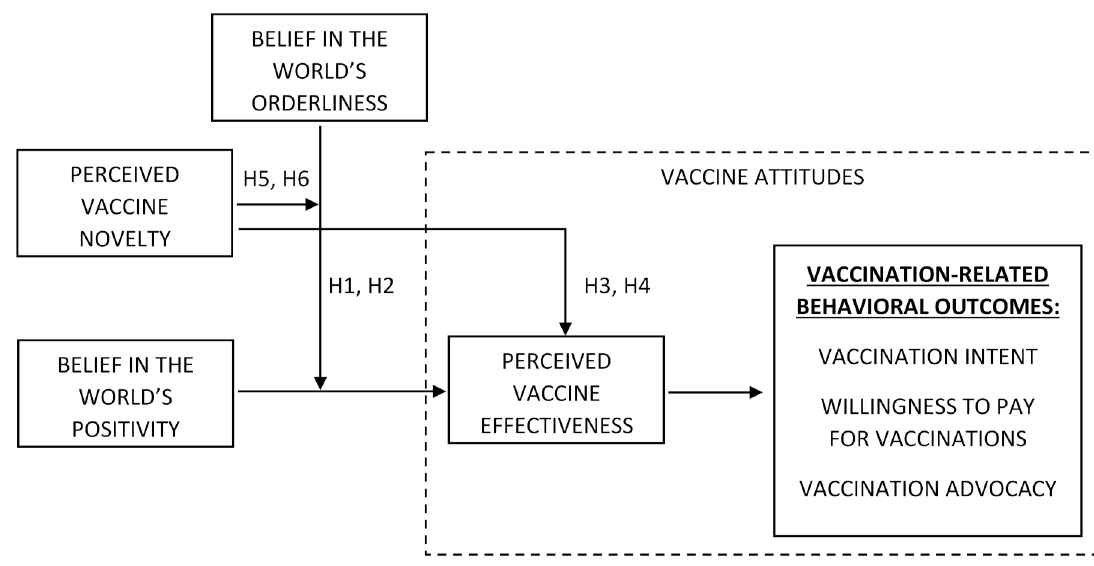
Figure 1. The conceptual